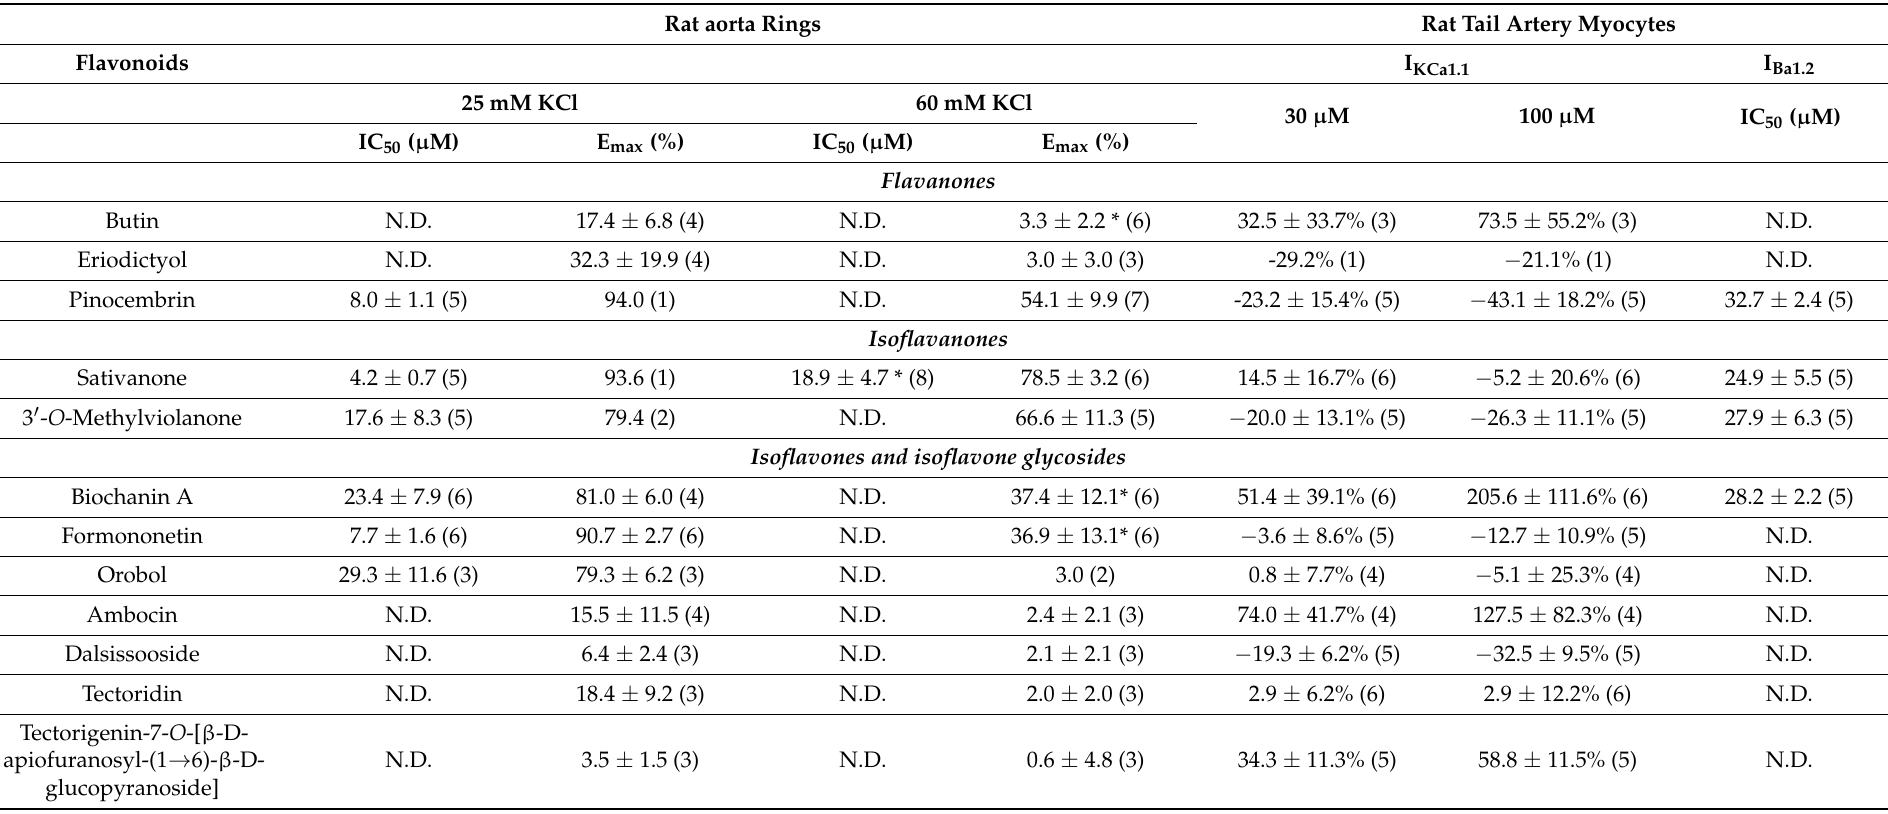
Table 1. Effects of Dalbergia isolates on KCl-induced contraction in rat aorta rings and on rat tail artery myocyte K Ca 1.1 and Ca V 1.2 channel